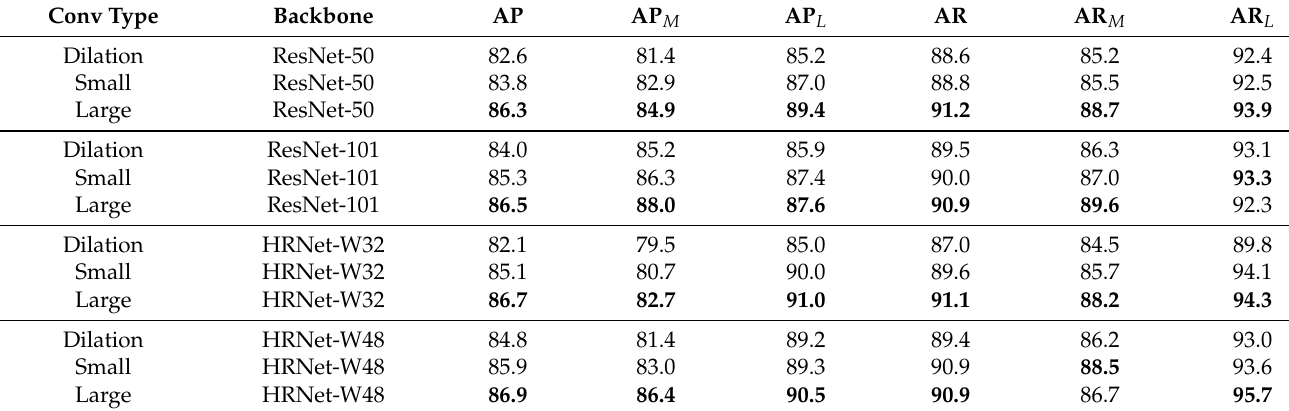
Table 3. Effect of different ways of extending the reception field on aircraft pose estimation.